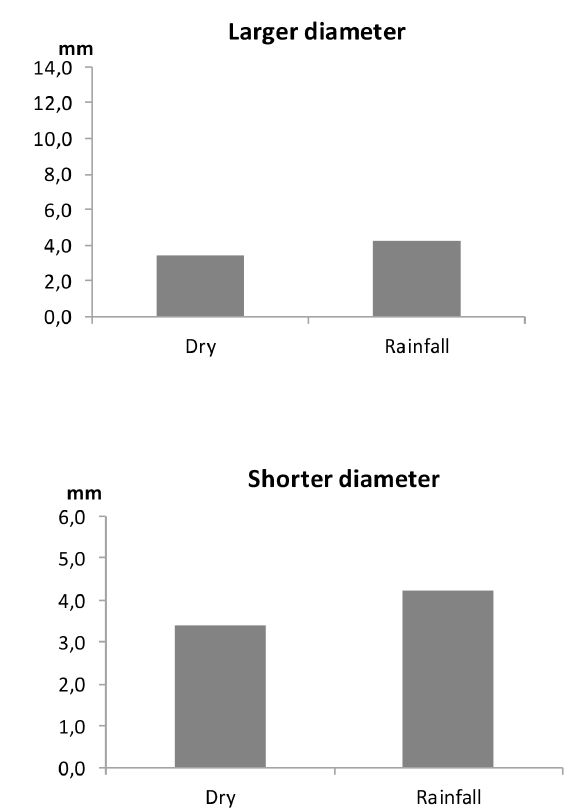
Figure 4. Mean and standard deviation of the longer (mm) and shorter (mm) axis of seminiferous tubules during the dry and rainy seasons. T-test for independent samples